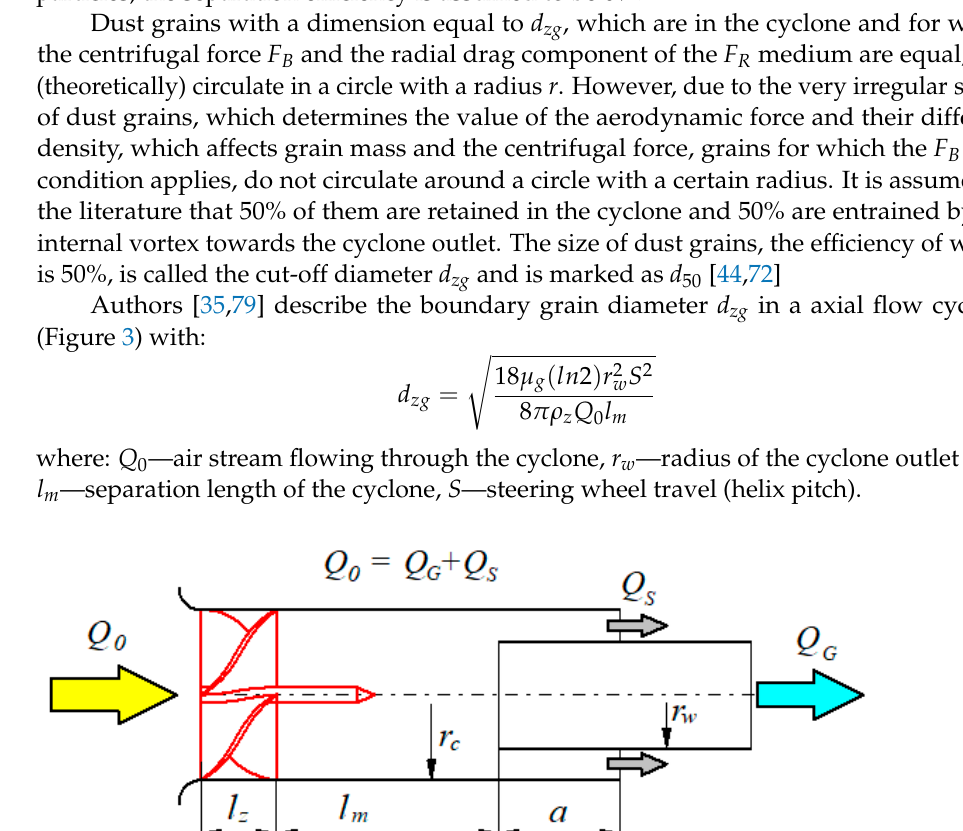
Figure 3. Characteristic dimensions and main elements of axial flow cyclone: Q G —stream of purified air flowing from the cyclone through an outlet pipe, Q s —air stream flowing from the cyclone together with separated solid particles, l z —length of the swirler, a —separation chamber length, r c —radius of the cylindrical part.